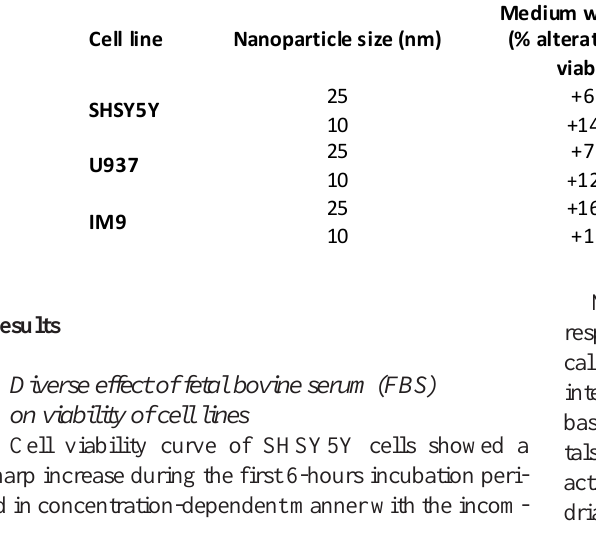
nanoparticles on viability of SHSY5Y, 2 at the end of 6-hour incu- 2